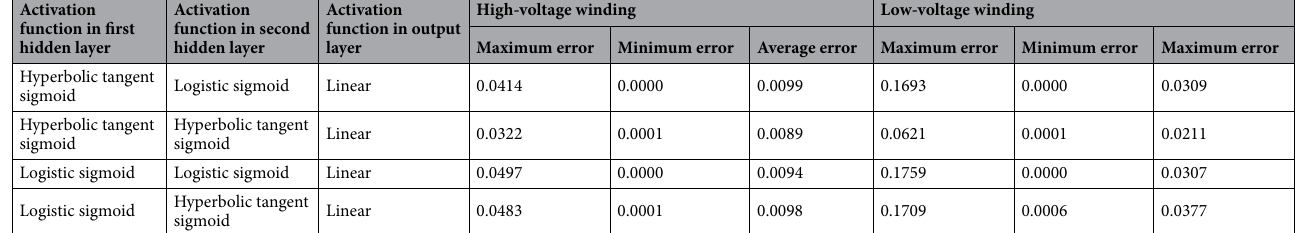
Table 4. Results of test using four best activation function